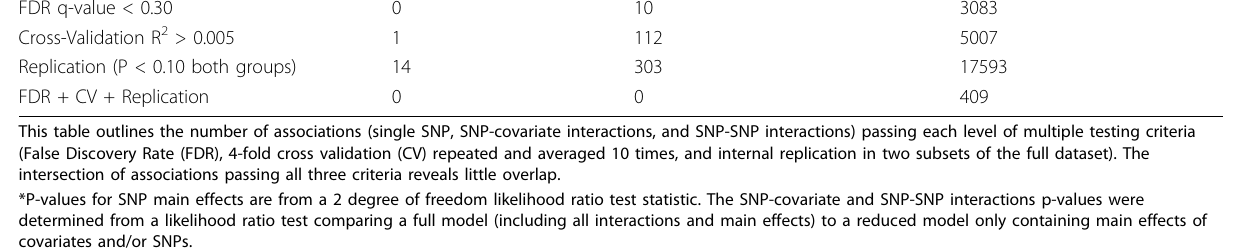
Table 2 Summary of the number of associations passing each of the three multiple testing criteria